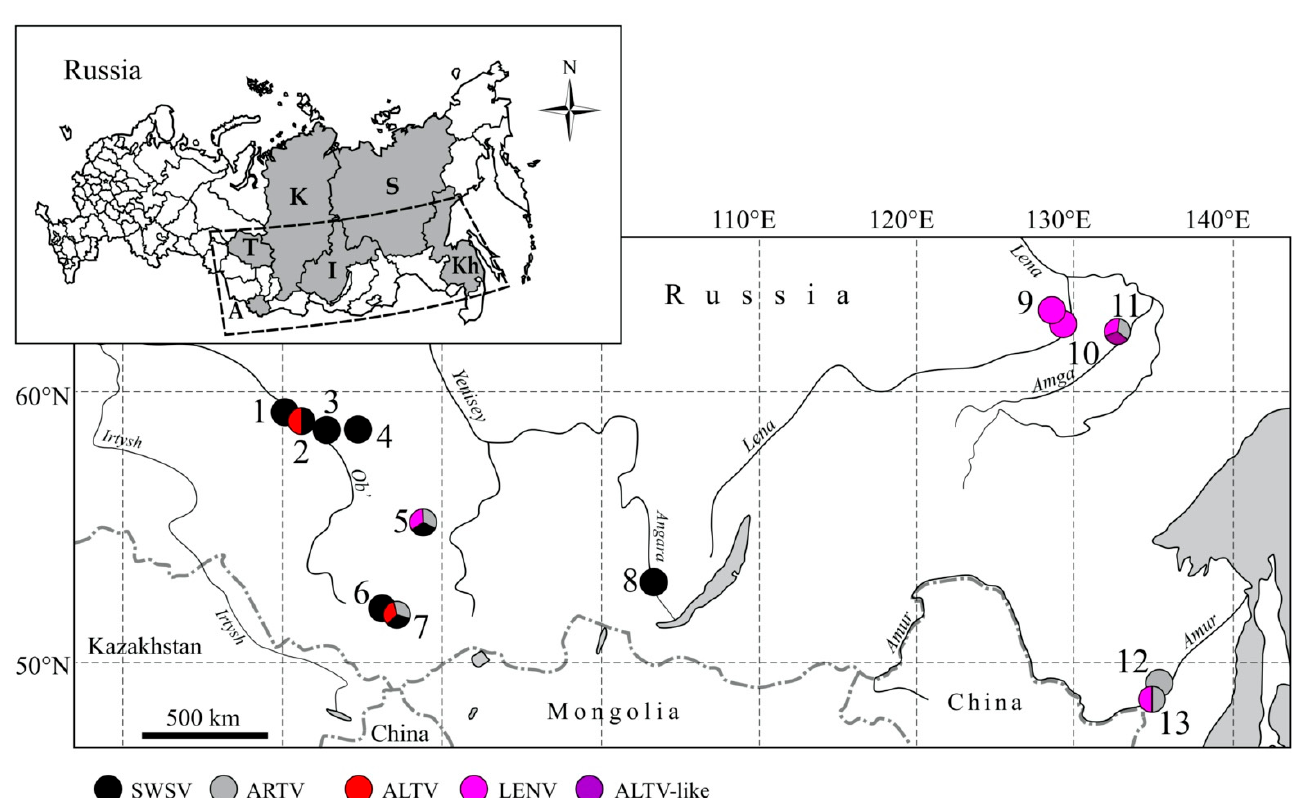
Figure 1. Map, showing the locations of the collection sites in Asian Russia, where hantavirus-infected Sorex shrews were captured. (1) Kargasok, (2) Parabel, (3) Volkovo, (4) Belyi Yar, (5) Parnaya, (6) Choya, (7) Teletskoye, (8) Irkutsk City, (9) Kenkeme River, (10) Lena River, (11) Amga River, (12) Galkino and (13) Khekhtsir. The inset shows the geographic locations of (A) Altai Republic, (T) Tomsk Oblast, (K) Krasnoyarsk Krai, (I) Irkutsk Oblast, (Kh) Khabarovsk Krai and (S) Sakha Republic. Samples for the present study are shown in bold type in Table 1. Detected hantaviruses are colored: Seewis virus (SWSV) (black), Artybash virus (ARTV) variant of SWSV (gray), Altai virus (ALTV) (red), Lena River virus (LENV) (magenta), ATLV ‐ like (purple).